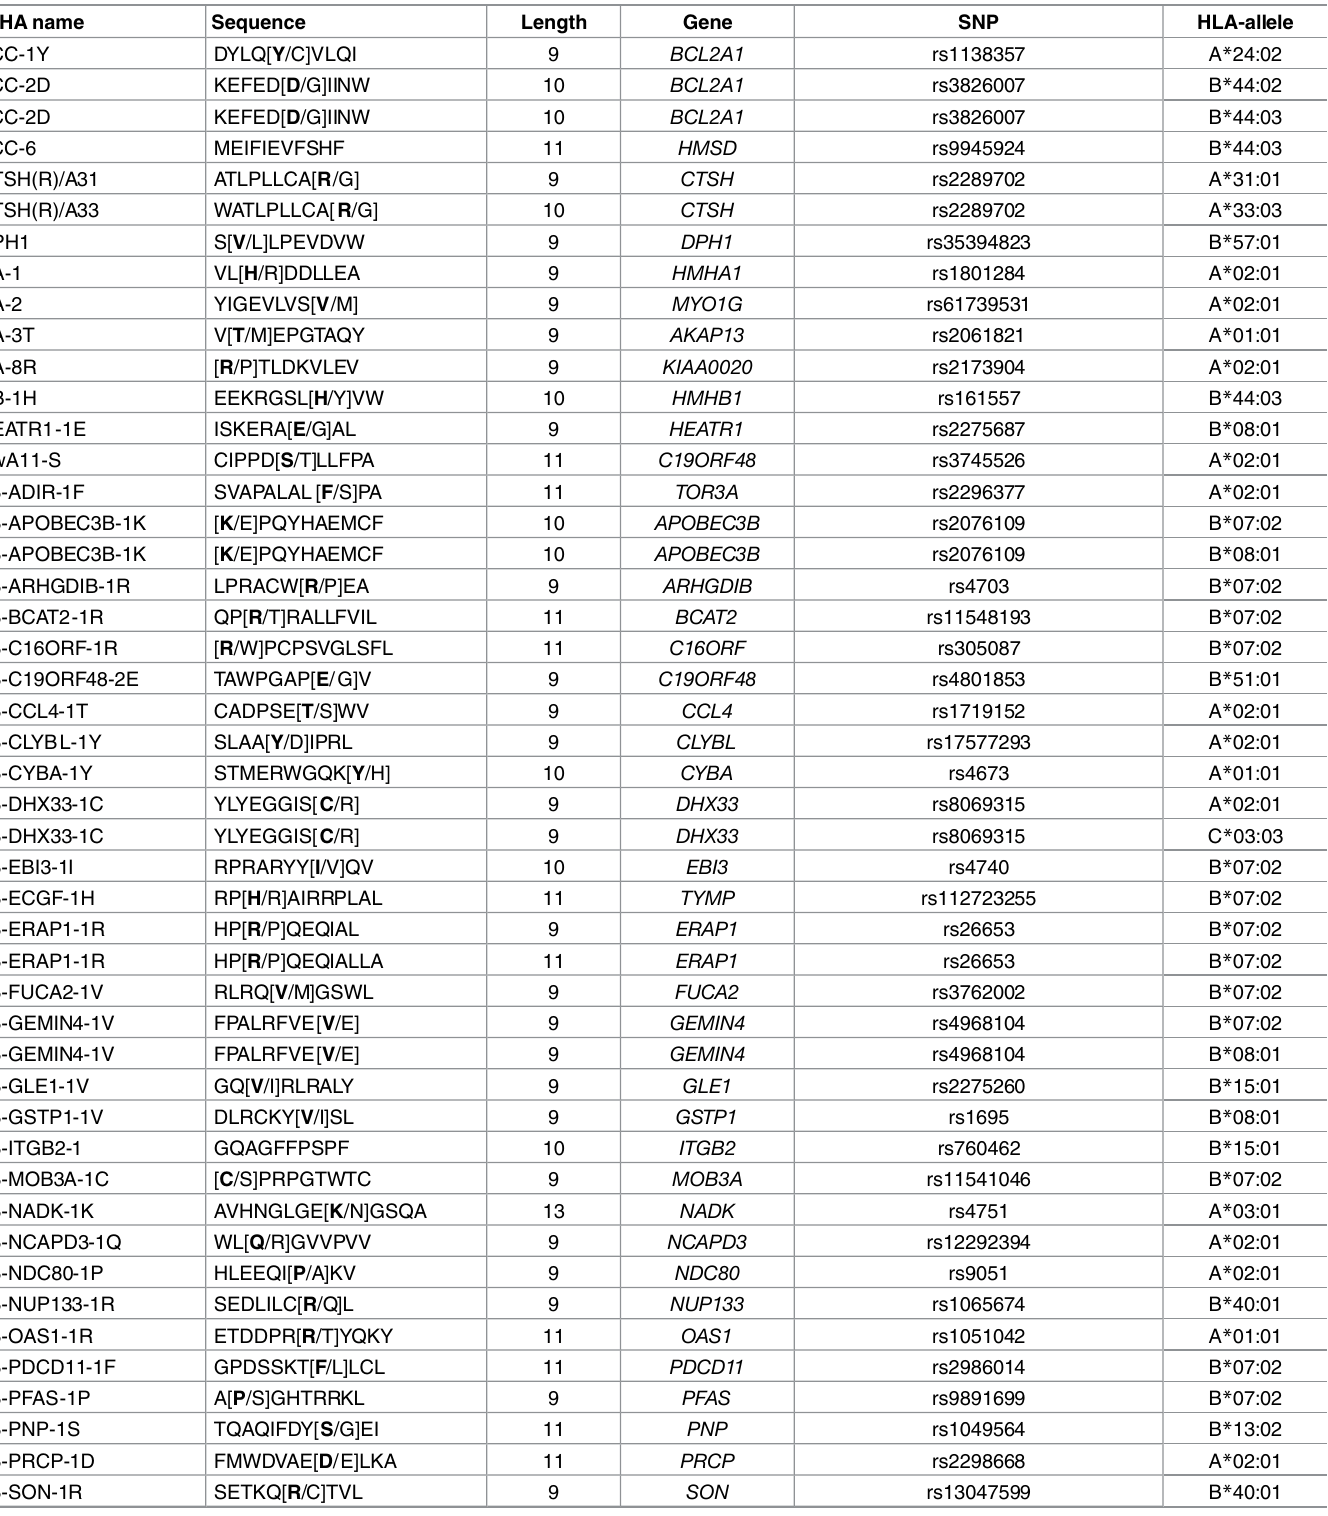
Table 1. HLA class